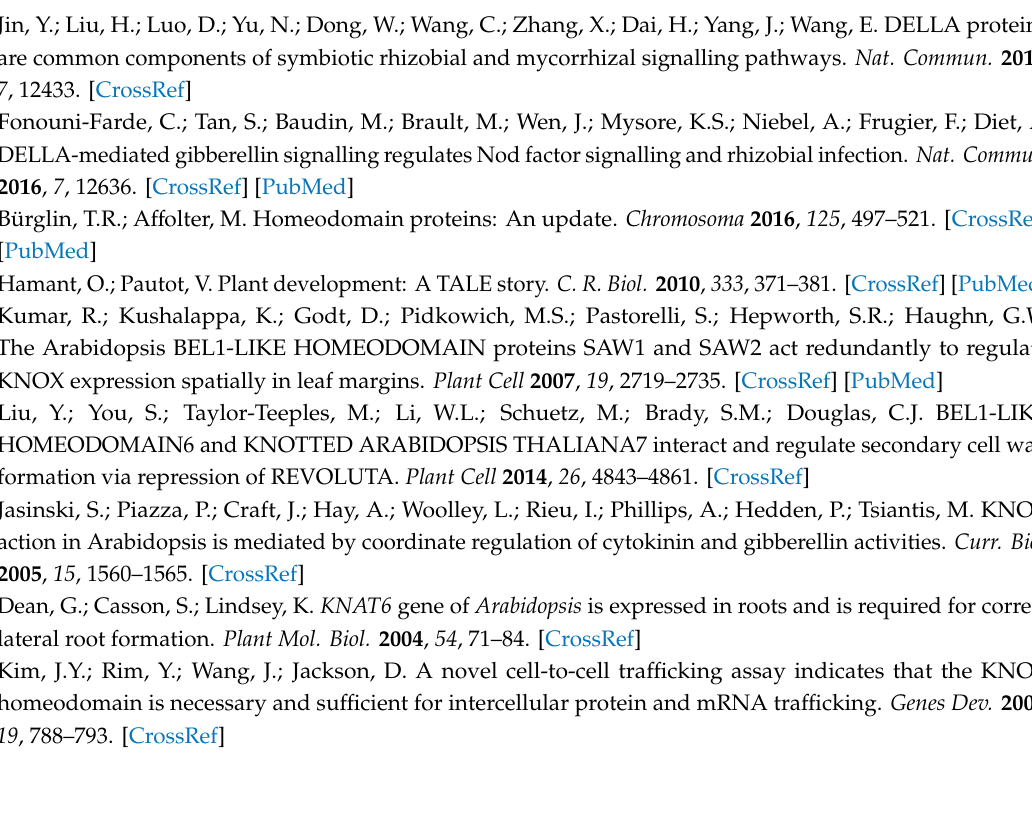
Table S1: Relationships between IDs of P. sativum , M. truncatula and A. thaliana BELL genes based on phylogenetic tree reconstruction; Table S2: IDs of L. japonicus BELL genes detected in ChIP-Seq analysis [18] as possible targets of NIN transcription factor and relevant fold enrichment score; Table S3: List of primers; Figure S1: Expression level of M. truncatula BELL genes based on re-analysis of RNA-Seq data from PRJNA552042 project using M. truncatula genome v.5 as a reference. Figure S2: Graphic illustration of data for P. sativum BELL genes expression in the roots and nodules based on RNA-Seq analysis; Figure S3: Graphic illustration of data for P. sativum BELL gene expression in the roots and nodules based on RNA-Seq analysis [43] using P. sativum genome sequence v1 as reference. Figure S4: Expression level of M. truncatula BELL genes in roots based on re-analysis of RNA-Seq data. Figure S5: Expression level of M. truncatula BELL genes in the di ff erent nodule zones. Data file: sequences of BELL genes for A. thaliana, O. sativa and